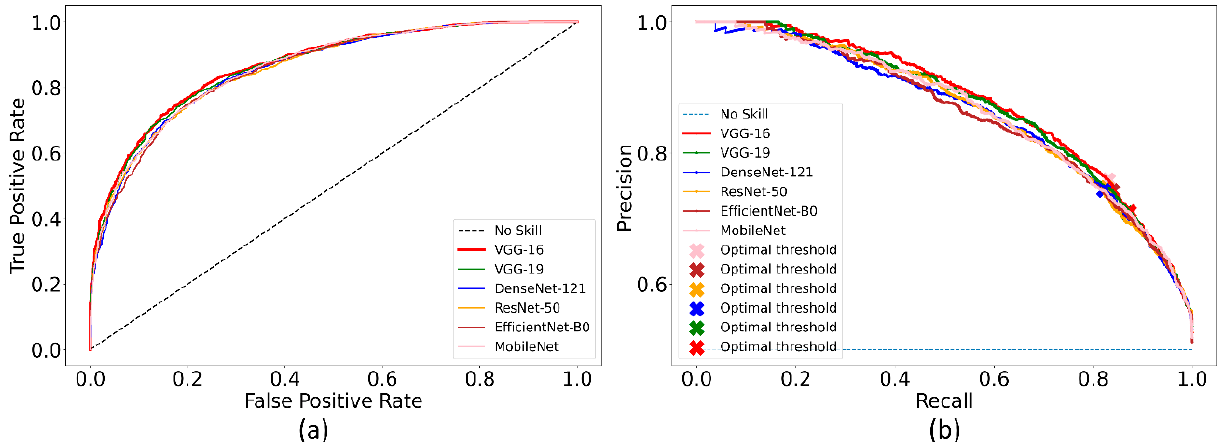
Figure 4. The collection of performance curves for the CXR image modality-specific retrained models. The performance is recorded at the optimal classification threshold measured with the validation data. ( a ) ROC and ( b ) PR curves.